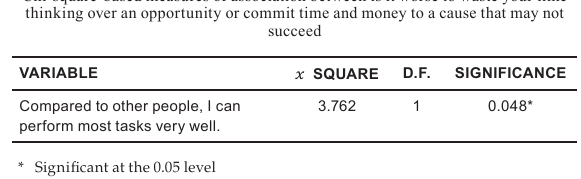
table 10 Chi-square-based measures of association between is it worse to waste your time thinking over an opportunity or commit time and money to a cause that may not